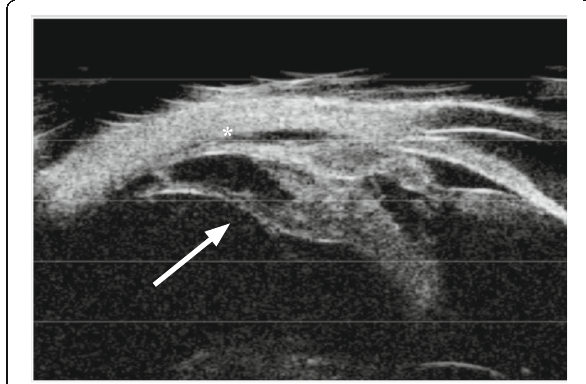
Fig. 3 Posterior extension of cyclitic membrane to pars plana (arrow) with peripheral choroidal detachment (asterisk). 1585 × 964 mm (72 × 72 DPI)